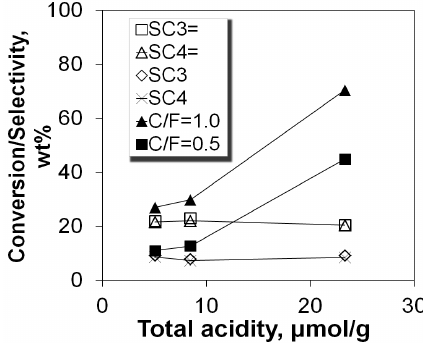
Figure 5. Correlation of n-C 12 conversion (C/F 0.5 and C/F 1.0) and product selectivities (propylene, total butylenes, propane, and total butanes) with the total acidity of the P/ZSM-5 additives (LPG selectivity values refer to ~47% constant conversion).